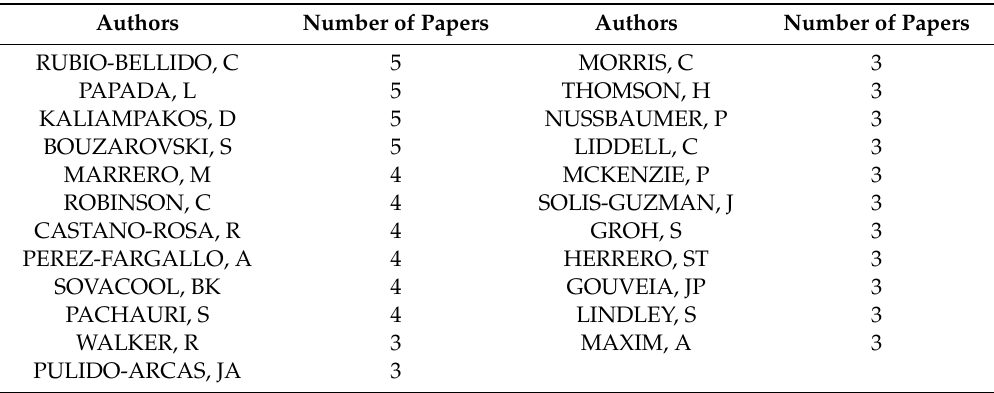
Table A2. Top 20 authors contributors in the field (since the 20th name in the list has 3 papers, it was included all the authors with that amount of publications). Authors Number of Papers